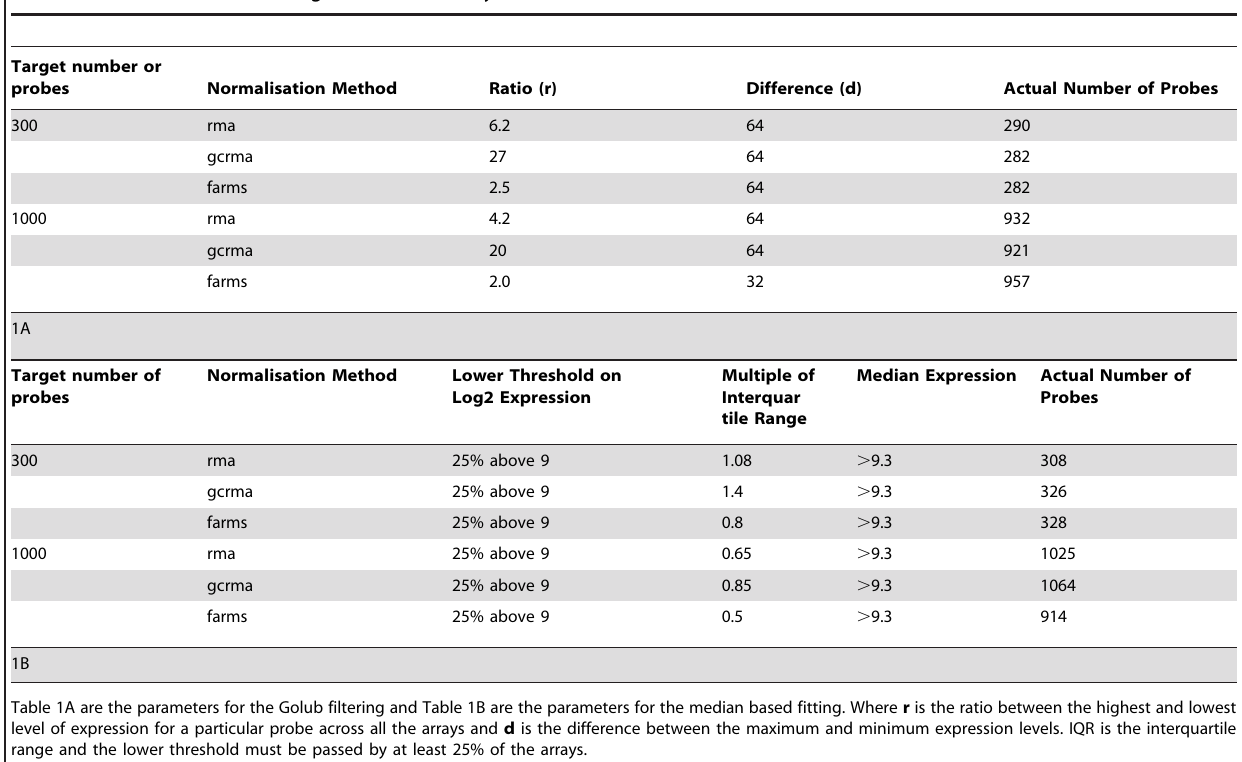
Table 1. Values for the Filtering of the Microarray Probeset Level Data.